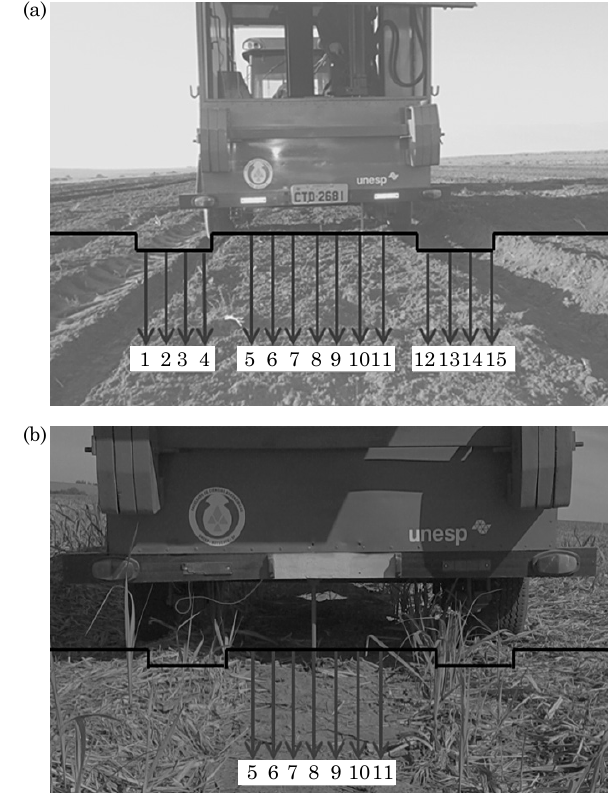
figure 4. Sampling points for data collection of soil penetration resistance in 2012 (a) and in 2013 (b).